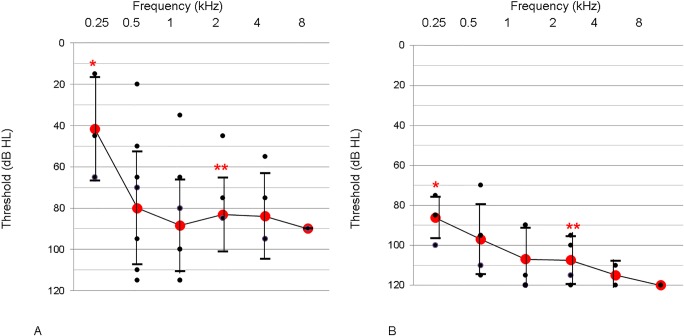
Overlapping audiograms of the patients with c.235delC and non-c.235delC GJB2 mutations.A. Patients with hearing loss caused by a c.235delC mutation (excluding patients with a p.V37I mutation in the trans configuration) (n = 13). B. Patients with hearing loss caused by a non-c.235delC mutation (excluding patients with a p.V37I mutation in the trans configuration) (n = 5). Detailed lists of non-c.235delC mutations are p.R143W homozygote, p.R143W single heterozygote, p.Glu47* and p.Ala171Glufs*40 compound heterozygote, and p.T86R and p.R143W compound heterozygote. (*p = 0.05, **p = 0.03, by the Mann-Whitney U test) (Black dots mean hearing thresholds of each subject, which may represent more than one subject with identical hearing thresholds. Red dots represent mean hearing thresholds of each frequency).